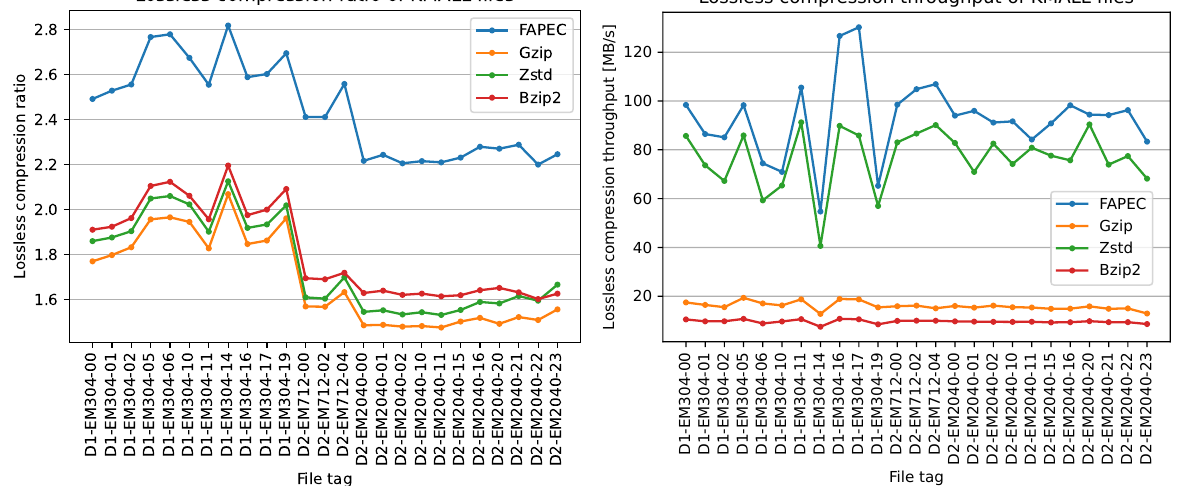
Figure 11. Lossless compression ratio ( left panel) and lossless compression throughput ( right panel) for the tested KMALL